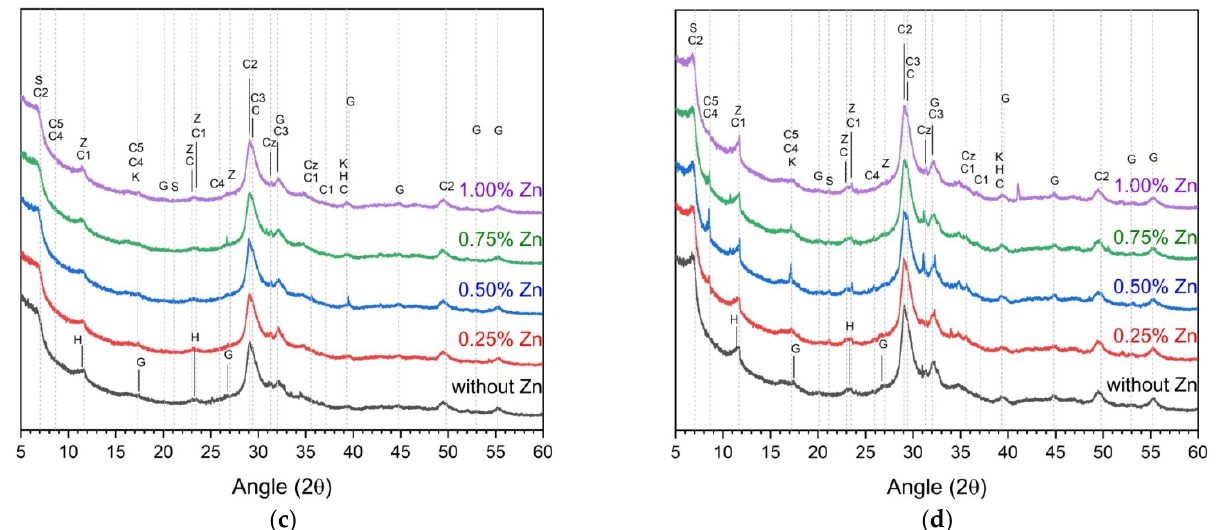
Figure 4. XRD analysis of samples with a w/b of 0.45 ( a ) cured at 23 ± 2 °C after 1 day, ( b ) cured at 23 ± 2 °C after 28 d, ( c ) cured at 40 ± 2 °C after 1 day, and ( d ) cured at 40 ± 2 °C after 28 d.